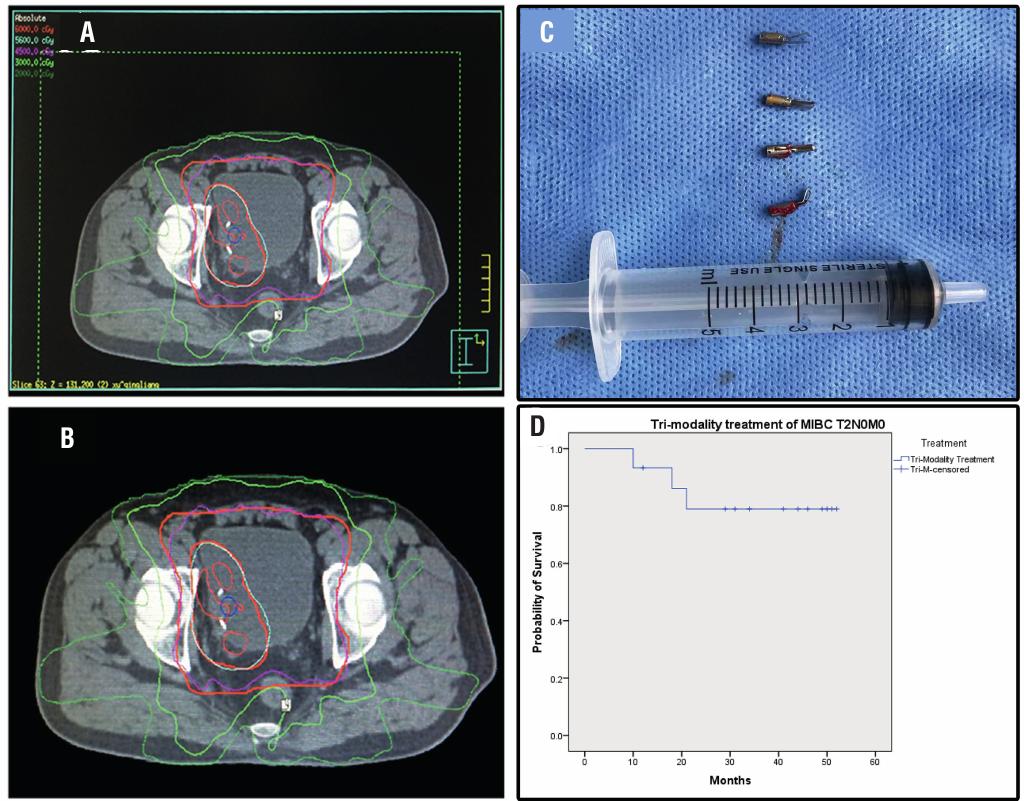
Figure 2 - Precision radiotherapy planning and follow-up, Kaplan-Meier